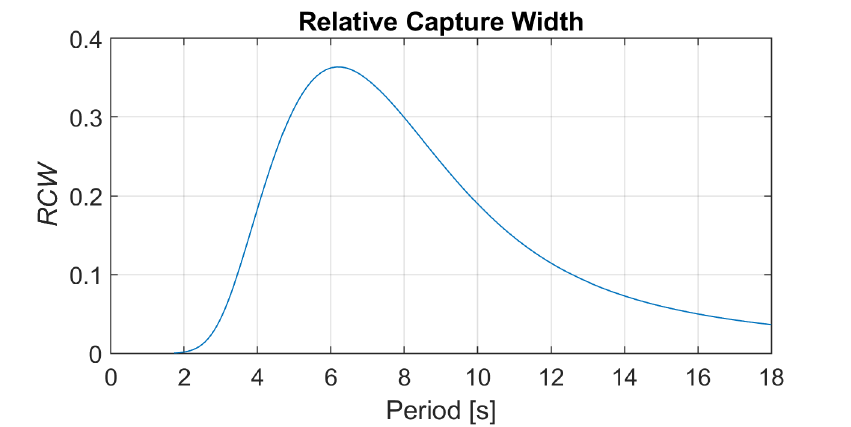
Figure 3. The relative capture width ( RCW ) curve of the WEC.